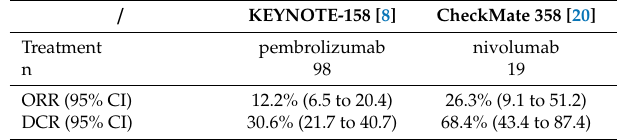
Table 2. Antitumor activity of KEYNOTE158 and CheckMate